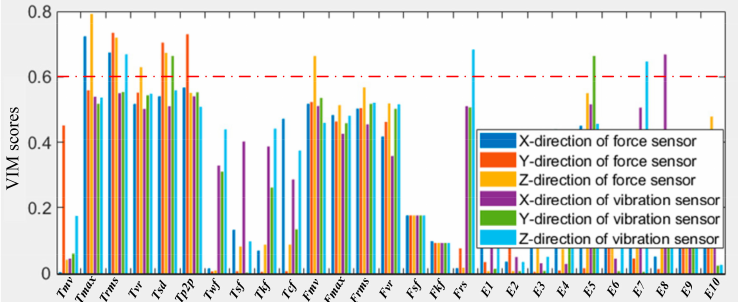
Figure 11. Comparison of variable importance measures (VIM) scores of the all extracted